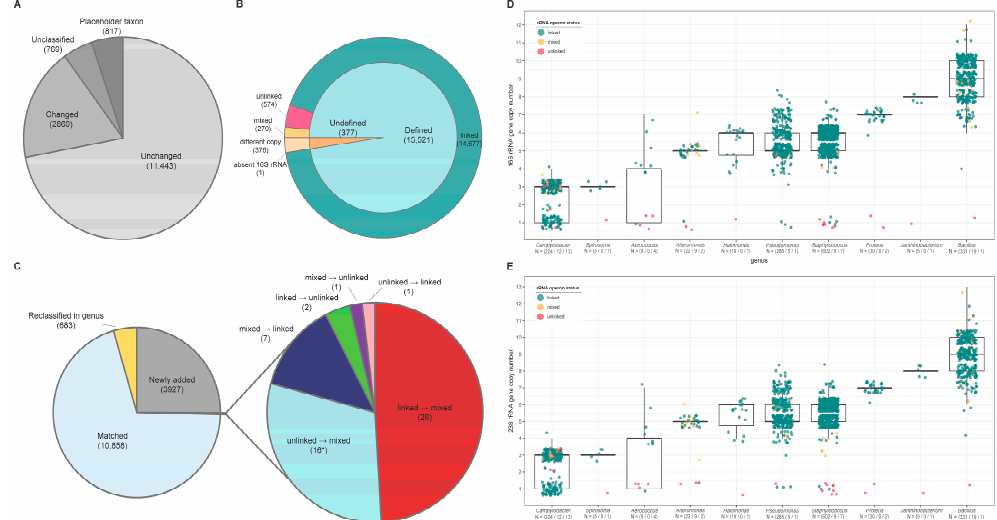
Figure 3. Results of genome screening. ( A ) Changes in taxonomy at the species level as a result of Genome Taxonomy Database (GTDB) reclassification; ( B ) the rRNA operon status of genomes used in this analysis; ( C ) differences from the previous analysis. Changes in taxonomy and operon status were indicated. * The group “unlinked → mixed” contained 13 “reclassified in genus.” ( D , E ) Distribution of rRNA gene copy numbers in a genus with a partially unlinked rRNA operon. The number of linked, mixed, and unlinked genomes for each genus was displayed on the x -axis, and each genome was plotted with green, yellow, and red dots. The thick line of the box represents the median, the line at the end of the box represents the first and third quartiles, and whiskers are 1.5× interquartile ranges. Dots that do not overlap whiskers are outliers. The number of 16S and 23S rRNA genes verified by in silico PCR was used. ( D ) 16S rRNA and ( E ) 23S rRNA. Annotation data in RefSeq were defined by using the NCBI prokaryotic genome annotation